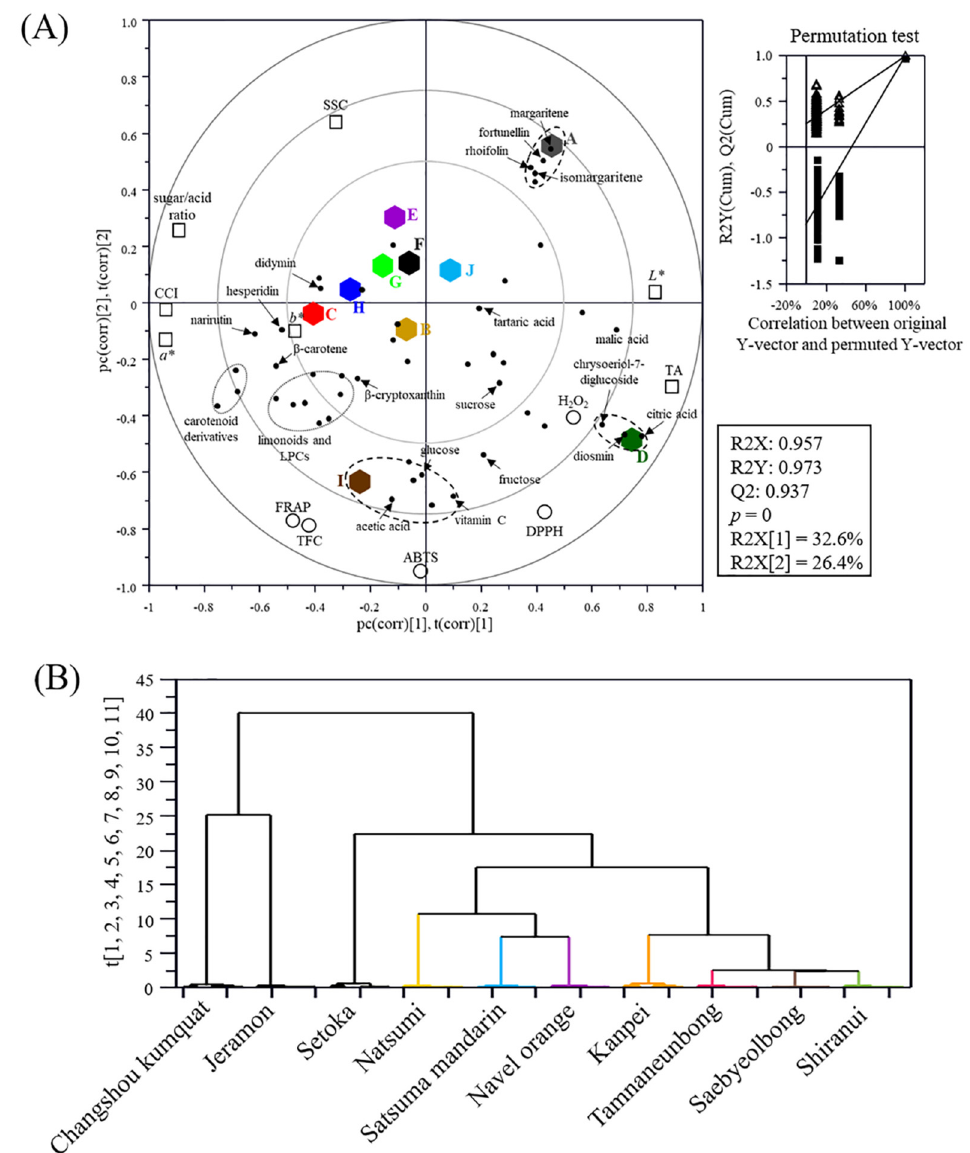
Figure 5. PLS-DA biplot ( A ) and hierarchical cluster analysis ( B ) of 10 citrus varieties based on the general quality parameters, antioxidant activities, and metabolite profiles. The qualification of the PLS-DA biplot was evaluated using R2X, R2Y, Q2, and p -values and validated using cross validation with a permutation test ( n = 200). A, Changshou kumquat; B, Satsuma mandarin; C, Natsumi; D, Jeramon; E, Saebyeolbong; F, Tamnaneunbong; G, Shiranui; H, Kanpei; I, Setoka; J, Navel orange; L* , lightness, a* , redness, b* , yellowness.